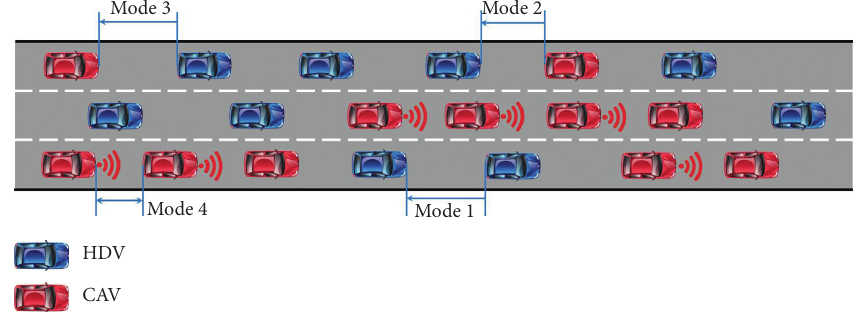
Figure 1: Four car-following modes of the mixed traffic flow. Table 1: The ratio of the four